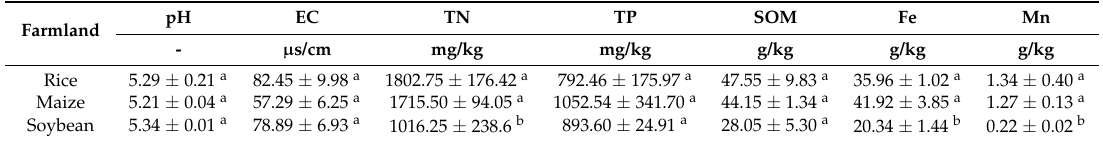
Table 1. Chemical properties of soil samples under different land